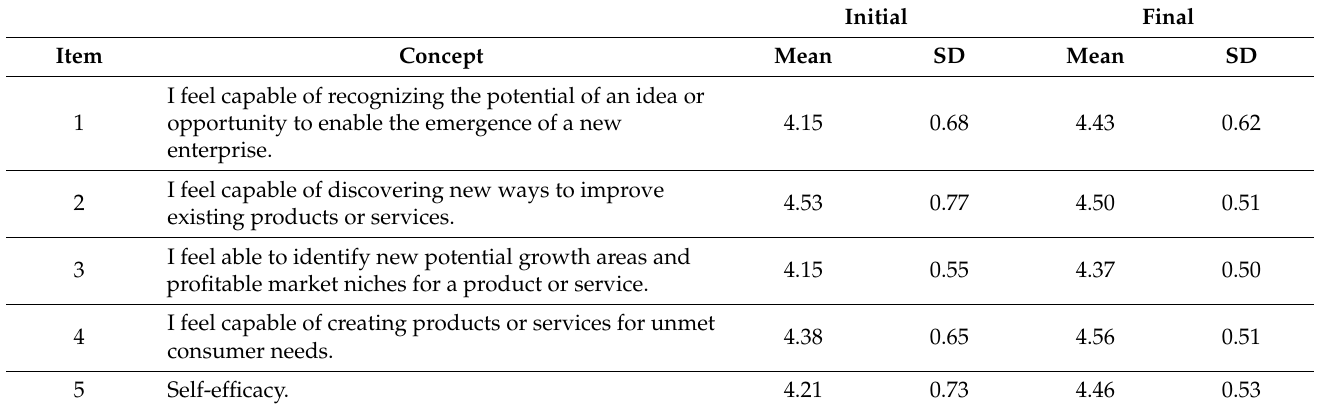
Table 7. Entrepreneurial self-efficacy competency results (Initial–Final).